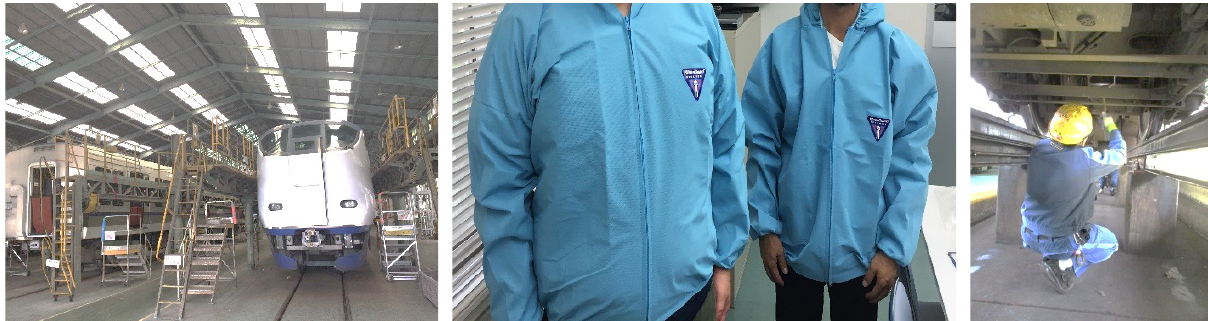
Figure 1. Example of hot specific working environment (train maintenance